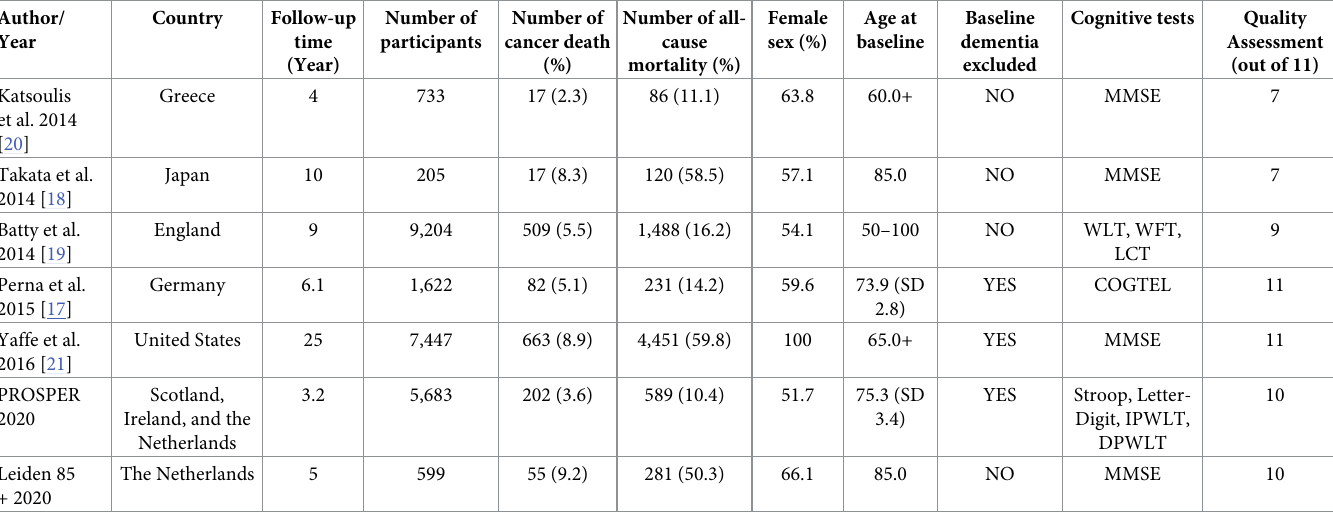
Table 5. Characteristics of studies included in systematic review and